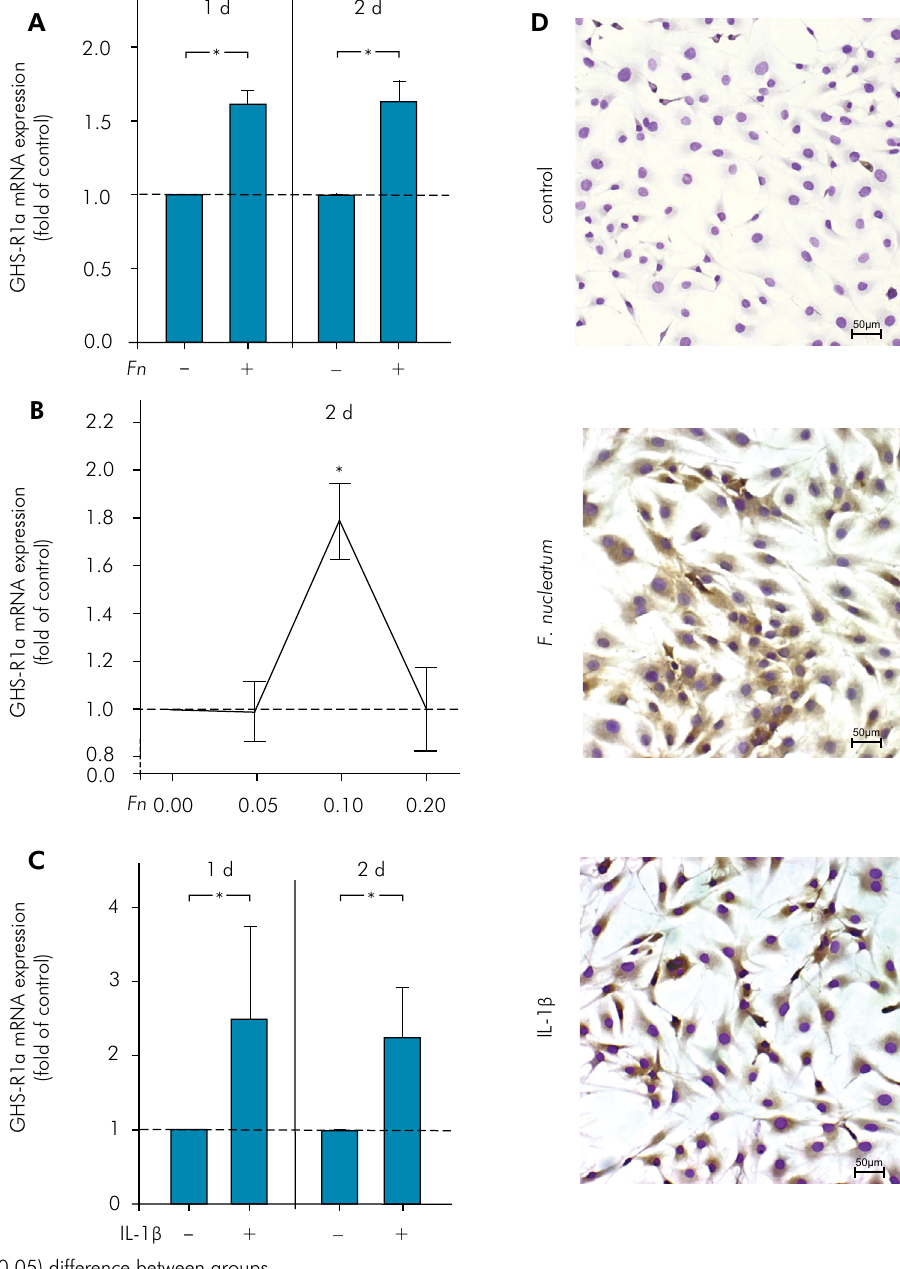
Figure 1. (A) GHS-R1a expression in the presence and absence of F. nucleatum ( Fn ; OD: 0.1) at 1 d and 2 d. Mean ± SEM ( n =9). (B) GHS-R1a expression in response to various concentrations of F. nucleatum ( Fn; OD: 0.05, 0.10, 0.20) at 1 d. Untreated cells served as control. Mean ± SEM ( n =9). (C) GHS-R1a expression in the presence and absence of IL-1 β (1 ng/ml) at 1 d and 2 d. Mean ± SEM ( n =9). (D) GHS-R1a immunoreactivity in the presence and absence of F. nucleatum (OD: 0.1) or IL-1 β (1 ng/ml) at 1 d. Representative images from one out of three experiments are